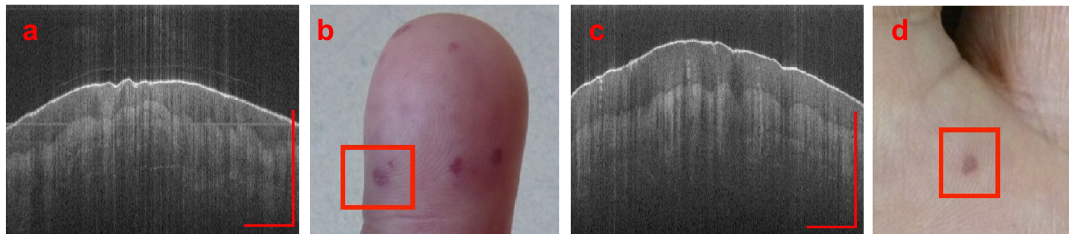
Figure 4. Two lesions from different patients demonstrating EFs and classifications. ( a ) is a superficial lesion, P2L2, with EF = 0.46 and ( b ) is the surface photograph of P2L2. ( c ) is a deep lesion, P1L1, with EF = 0.93 and ( d ) is the surface photograph of P1L1. The axis in each image represents a 1 mm × 1 mm